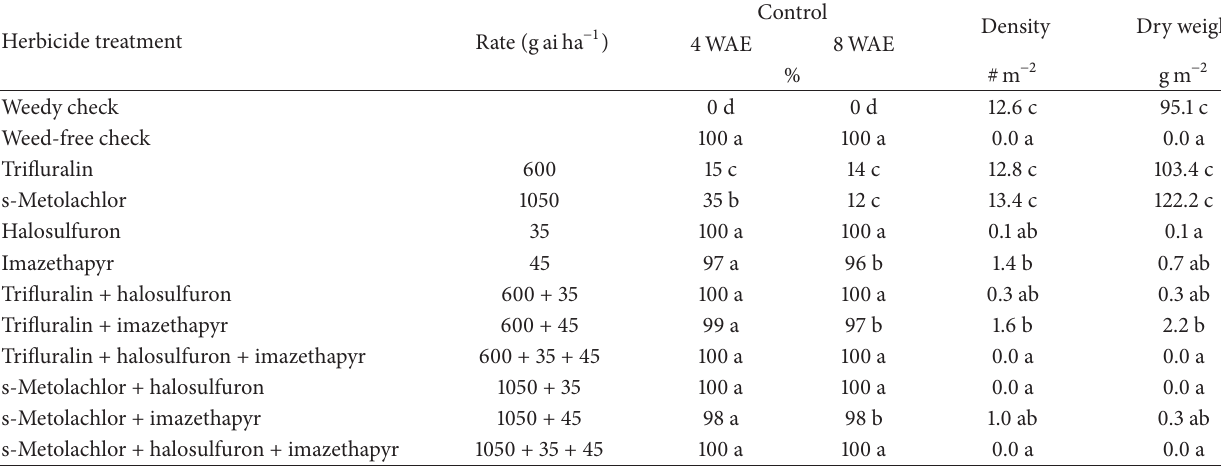
Table 5: Percent control, density, and dry weight of wild mustard in white bean treated with halosulfuron tankmixes applied PPI at Exeter, ON (2011 and 2013). Means followed by the same letter within a column are not significantly different according to Fisher’s Protected LSD at 𝑃 < 0.05 a . Herbicide treatment